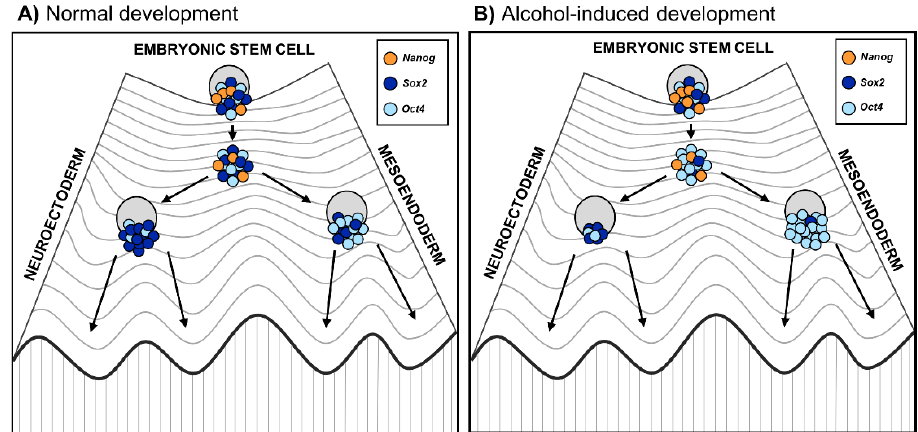
Figure 2. Embryonic stem cell differentiation into germ layers during ( A ) normal embryonic development and ( B ) altered development due to prenatal alcohol exposure. The Waddington’s epigenetic landscape reflects the differentiation of cells, where the fate of stem cells depends on their history as well as developmental and environmental inputs [76]. On the highest hill are ESC progenies that progress toward differentiation. Changes in epigenetic modifications in ESC progenies lead to a reconfiguration of the core transcription factors Oct4, Sox2, and Nanog, represented as a Waddington’s landscape [77]. Coming down to the hill, stem cells first reach a plateau with low Nanog expression that enables them to respond to differentiation signals. ( A ) During normal stem cell differentiation, higher Oct4 expression induces stem cells toward the mesoendoderm progenitor cell fate, while higher Sox2 drives stem cells toward the neuroectoderm progenitor cell fate; ( B ) During alcohol-altered stem cell differentiation, alcohol affects the balance of the core pluripotency factors, especially Oct4/Sox2 ratio [74]. Therefore, alcohol may reprogram lineage specification favoring excess of Oct4 relative to Sox2 and forcing stem cells down the differentiation trajectory away from neuroectoderm.